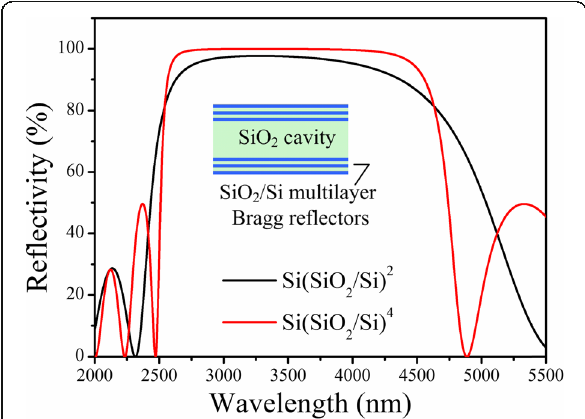
Fig. 2 Comparison of simulated reflective spectra of Bragg reflectors with 2 pairs and 4 pairs of Si/SiO 2